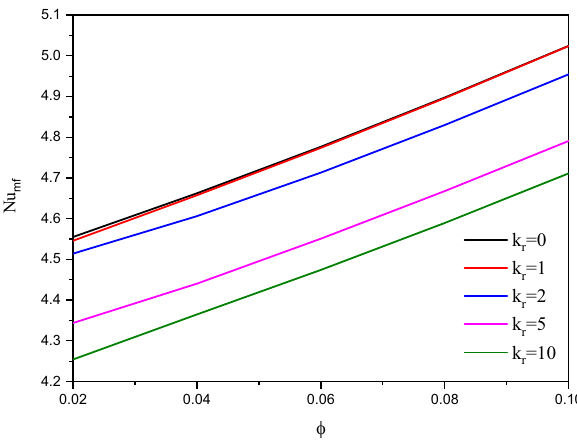
Figure 18. Variation of Nu mf below the changes on a modified conductivity ratio k r for a hybrid nanofluid at